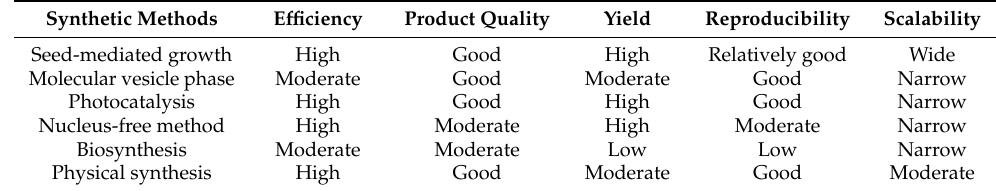
Table 2. Comparisons on the reported synthetic methods of AuNTs regarding the efficiency, product quality, yield, reproducibility and